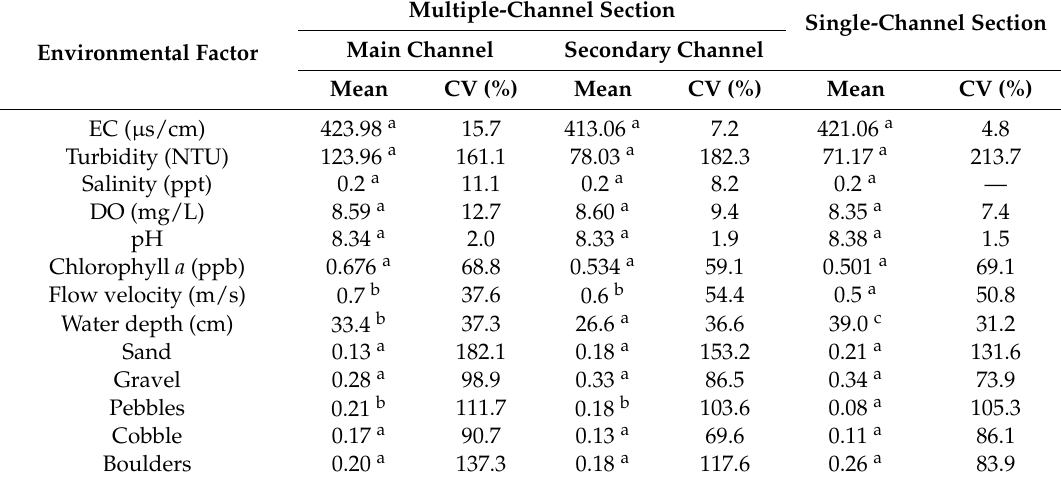
Table 2. Mean and CV for environmental factors in the two sections. The different letters are significantly different according to the Duncan post-hoc analysis ( p < 0.05) for the means, and the order is indicated by: a < b < c. “—” represents no value because the standard deviation is